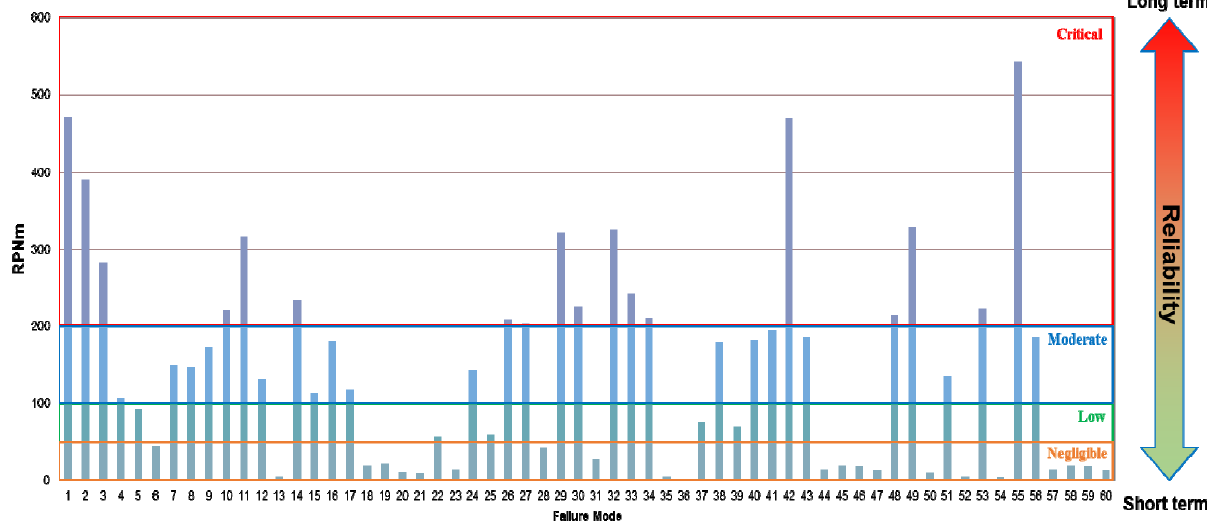
Figure 15. Failure mode RPN in the development of advanced flexible